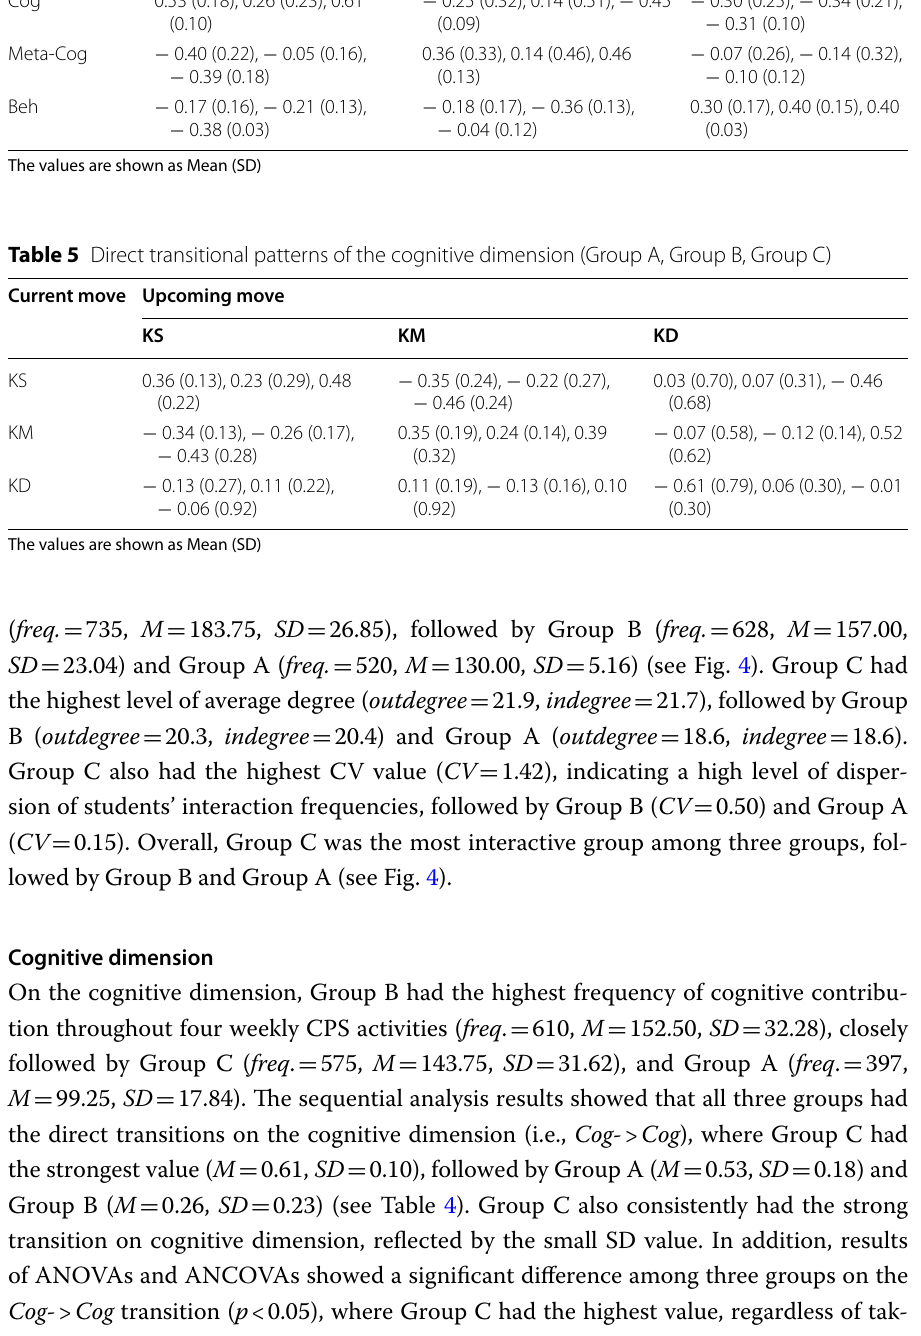
Table 4 Direct transitions of the cognitive, metacognitive and behavioral dimensions (Group A, Group B, Group C)